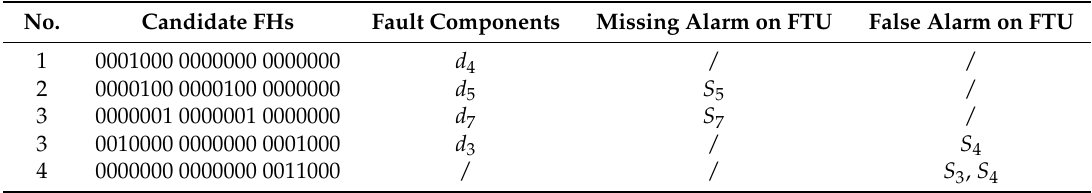
Table 4. Diagnoses using the upper-level analytic model in scenario 1 and